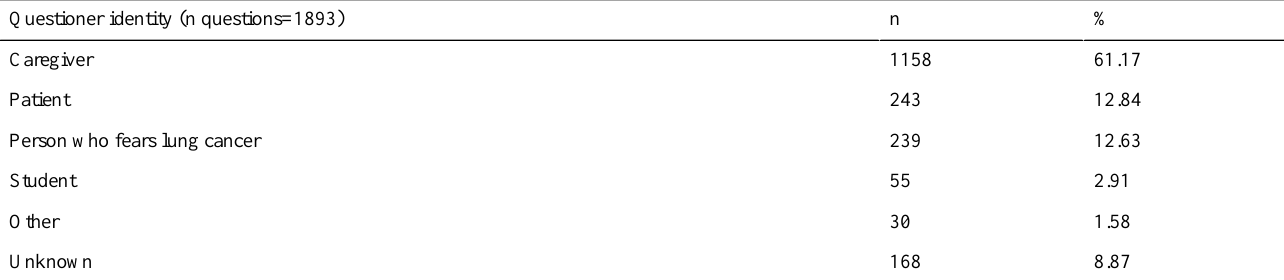
Table 2. Questioner’s identity type.